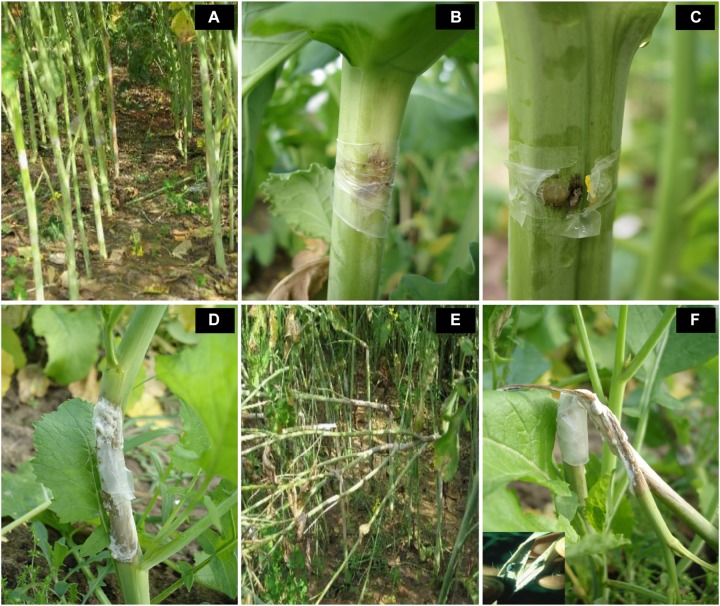
Variation in resistance responses of B. juncea–E. cardaminoides introgression lines, three weeks after stem inoculation with Sclerotinia sclerotiorum. (A–C) reflect highly resistant reaction. Susceptibility of recipient parent and some introgression lines was indicated by a soft watery lesion (D) or stem breakages due to very long lesions that girdled the stem (E,F).